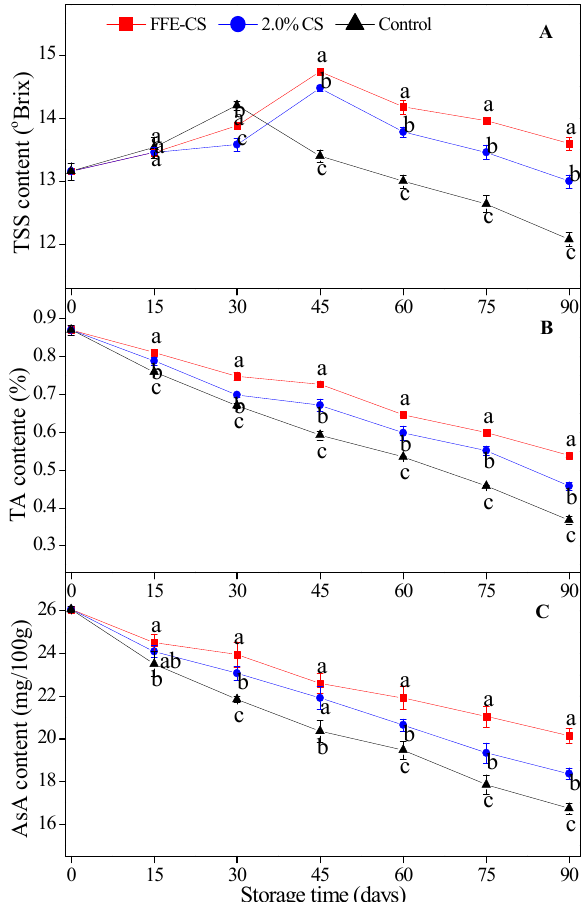
Figure 2. Effect of FFE-CS coating on the contents of total soluble solid (TSS) ( A ), titrable acid (TA) ( B ) and ascorbic acid (AsA) ( C ) of Xinyu tangerines during cold storage of 90 days. Differences between treatments for each time were analyzed using Duncan’s multiple range test at P < 0.05.